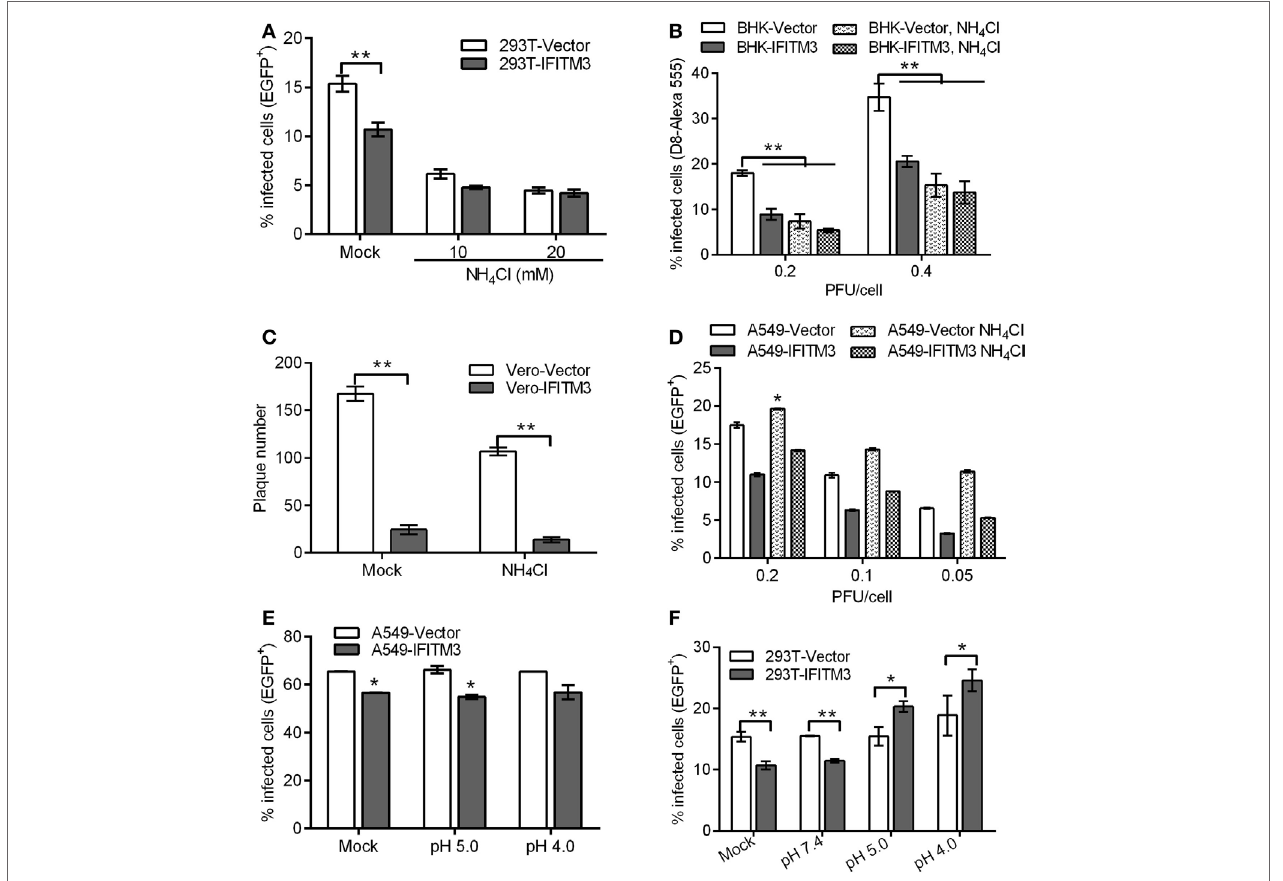
FigUre 8 | Interferon-inducible transmembrane protein 3 (IFITM3) overexpression affects pH-dependent vaccinia virus (VACV) entry. (a,B) IFITM3 + 293T and baby hamster kidney cells were infected with vaccinia virus Tian Tan green fluorescent protein (VTT-EGFP) at the indicated MOI on ice for 1 h, followed by either mock treatment or treatment with 10 or 20 mM NH 4 Cl at 37°C for 24 h. Percentages of infected cells were determined by flow cytometry. (c) Plaque forming assay of Vero cell lines, which were incubated with VTT at 0.01 MOI on ice for 1 h and then treated with 10 mM NH 4 Cl or buffer (mock) at 37°C for 48 h. (D–F) A549 or 293T cells were incubated with VTT-EGFP at the indicated MOI on ice for 1 h and then treated with 10 mM NH 4 Cl or PBS buffer (mock) (D) and pH 5.0 buffer, pH 4.0 buffer, or PBS (mock) (e,F) at 37°C for 24 h. Percentages of infected cells were determined by flow cytometry. All values represent the mean ± SD, n = 3. * P < 0.05 and ** P <